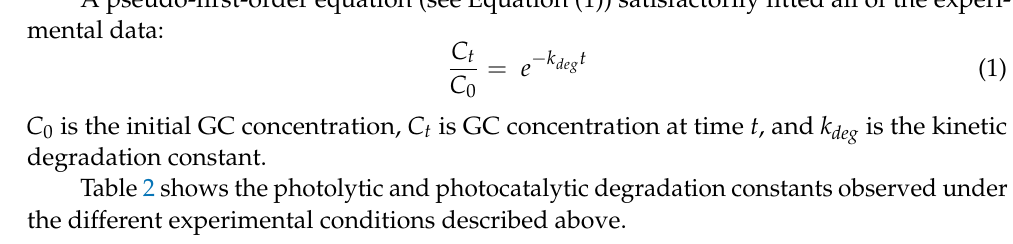
Figure 1. Evolution profiles of each GC (50 µ g L − 1 ) in tap ( a ) and river water ( b ) under simulated sunlight: CORT ( HCORT ( ∗ ), BETA ( × ), DEXA ( (cid:52) ), PRED ( (cid:3) ), PREDLO (+), and TRIAM (